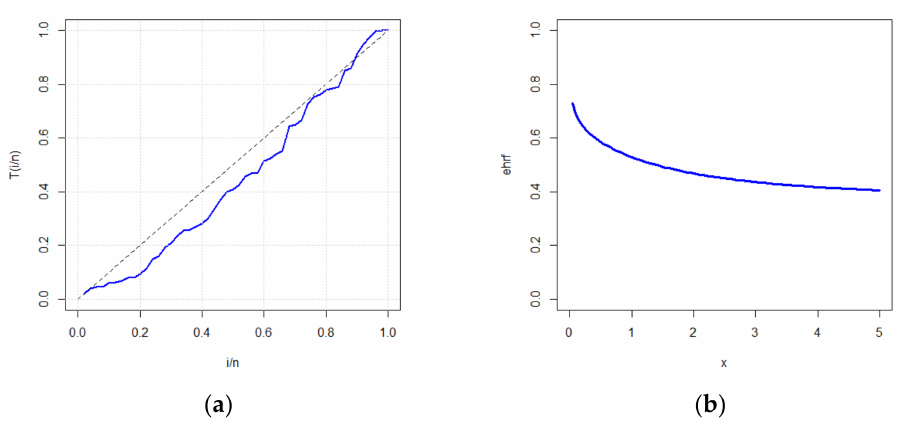
Figure 2. Plot of ( a ) TTT, and ( b ) the estimated hrf (ehrf) for the carbon fibers data